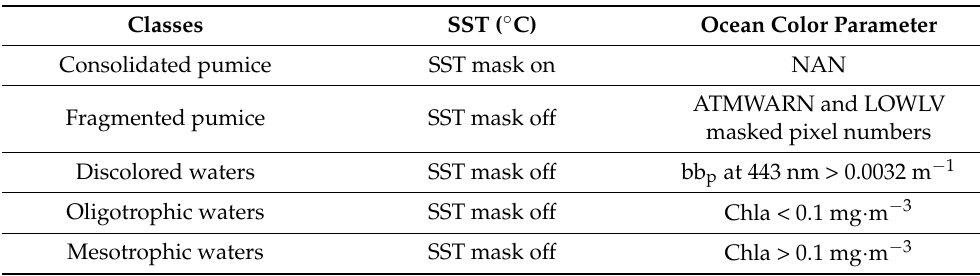
Table 2. Thresholds defined for different parameters using L2 MODIS and VIIRS SST and ocean color information.